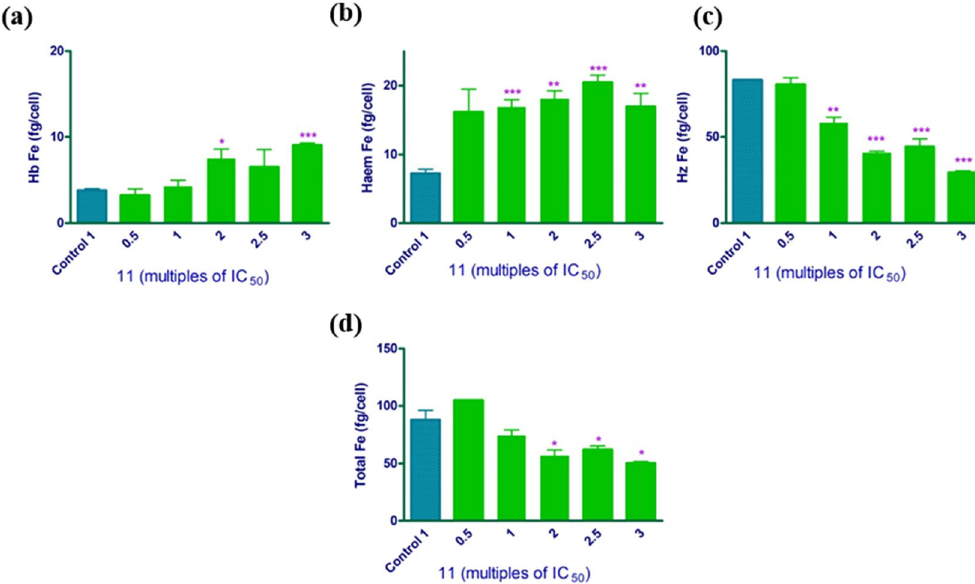
Figure 4. Intraparasitic haemoglobin ( a ), freely exchangeable haem ( b ), haemozoin ( c ) and total intraparasitic haem ( d ) in isolated P . falciparum trophozoites following 32 h incubation with compound 11 at multiples of its IC 50. Control: untreated cells, with haem expressed in fg Fe/cell. Statistical significance was calculated using a two-tailed t-test (error bars showing 95% CI) and is expressed relative to the control using